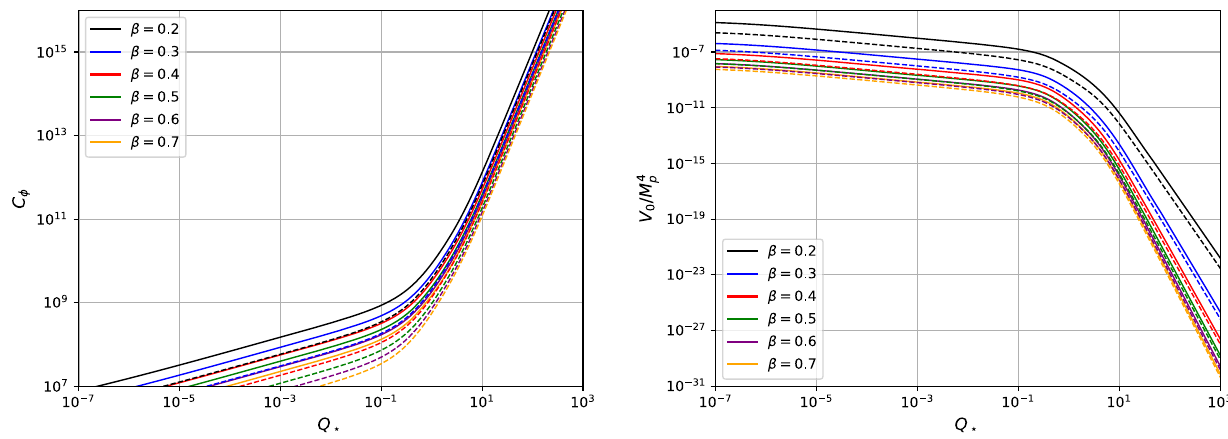
Fig. 4 The coefficient C φ is shown as a function of Q (cid:10) , for the same values of β as in Fig. 1 (left panel). On the right panel, we have the amplitude of the potential V 0 also as a function of Q (cid:10) . Once more, solid lines correspond to λ = 0 . 05, while dashed lines correspond to λ = 0 . 07